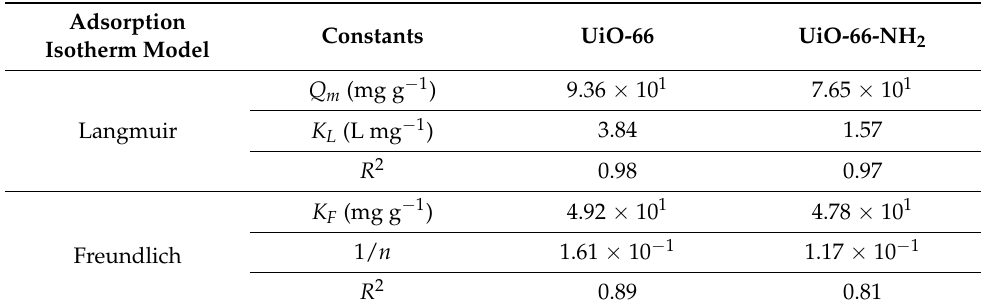
Table 3. Adsorption kinetics parameters of Langmuir and Freundlich isotherm models for TCs on UiO-66 and UiO-66-NH 2